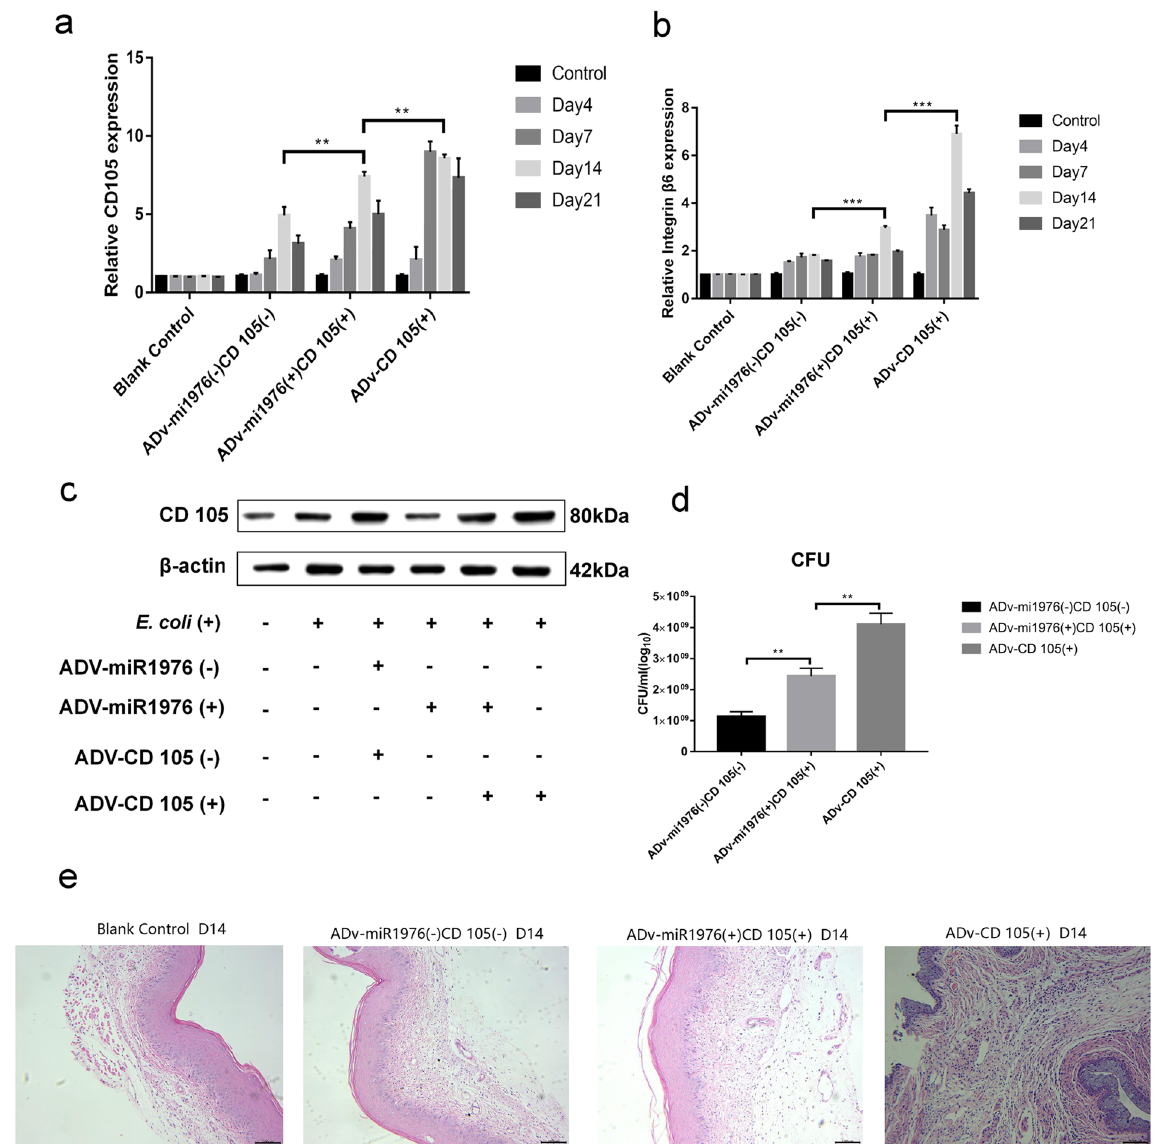
Figure 6. Simultaneous overexpression of miR1976 and CD105 ameliorated the deterioration of vaginal infection induced by CD105 overexpression. ( a ) Effects of miR1976 and CD105 overexpression on CD105 mRNA expression; ( b ) The change in the integrin α v β 6 mRNA level in the vaginal tissue of mice; ( c ) The change in CD105 protein expression after administration of the miR1976 and CD105 overexpression adenoviral vectors; ( d ) The number of vaginal microbes in the CD105 and miR1976 combination group was significantly lower than that in the CD105 adenoviral vector group; ( e ) Histological analysis indicated the alleviation of vaginal infection in the CD105 and miR1976 combination group compared with that in the CD105 adenoviral vector